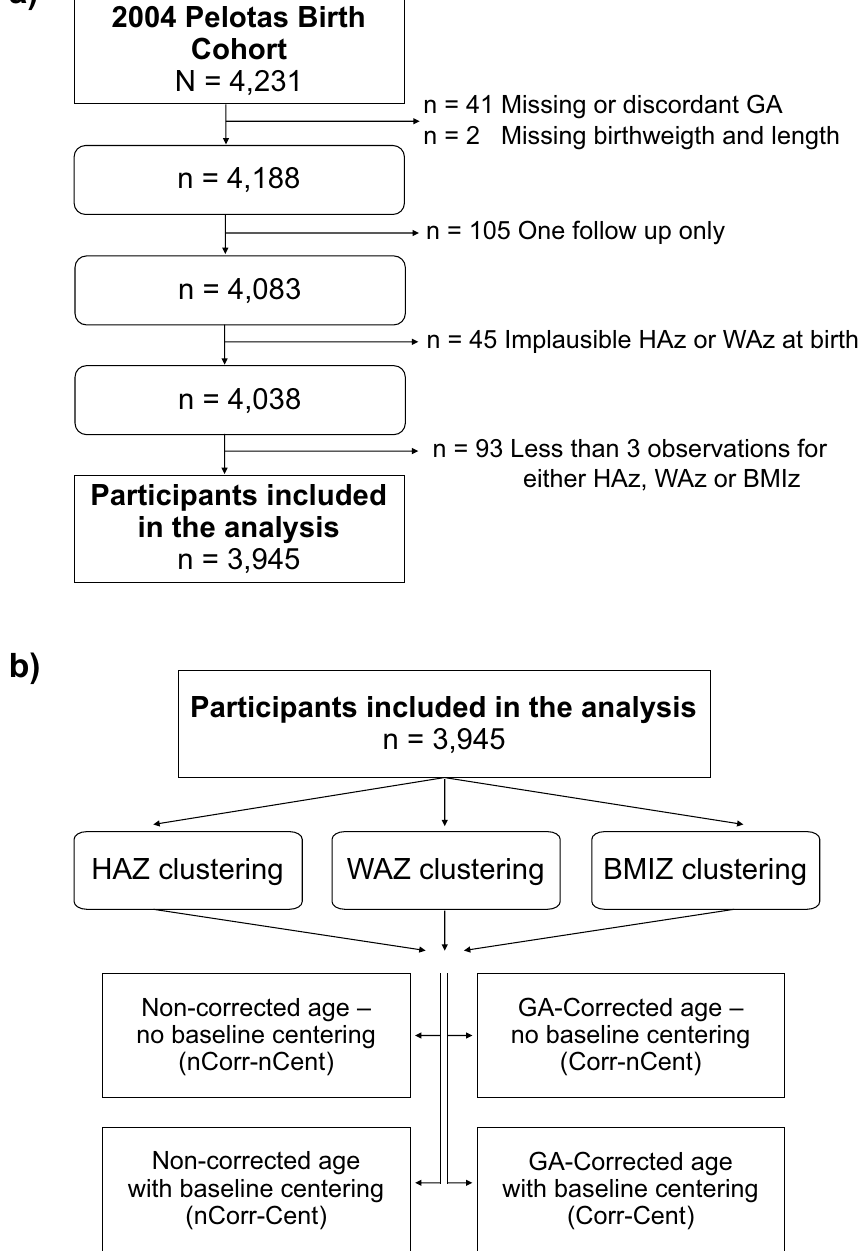
Figure 1. Flowchart of participants and analytical approaches tested. Participants were excluded if missing or discordant GA (n = 41), if missing or implausible birthweight or length variables (n = 47), if having only one follow up (n = 105), and those with < 3 observations for either HAz, WAz or BMIz (n = 93). GA, gestational age; HAZ, Height-for-age z-score; WAZ, Weight-for-age z-score; BMIZ, body mass index